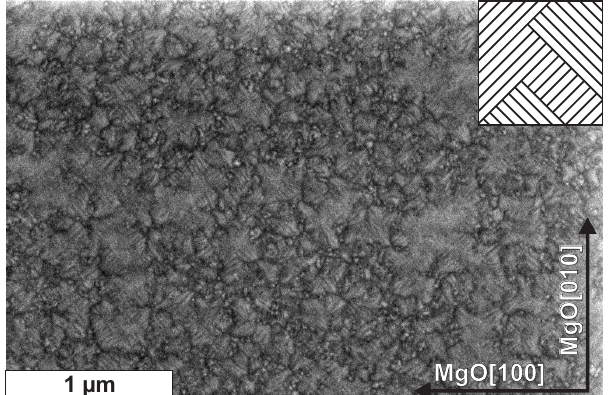
Figure 4. SEM picture of an as-deposited Fe the pictures are parallel to MgO (cid:104) 100 (cid:105) . On the film surface, a fine twinned structure with 45 ◦ to MgO (cid:104) 100 (cid:105) edges is observed, which is shown schematically in the